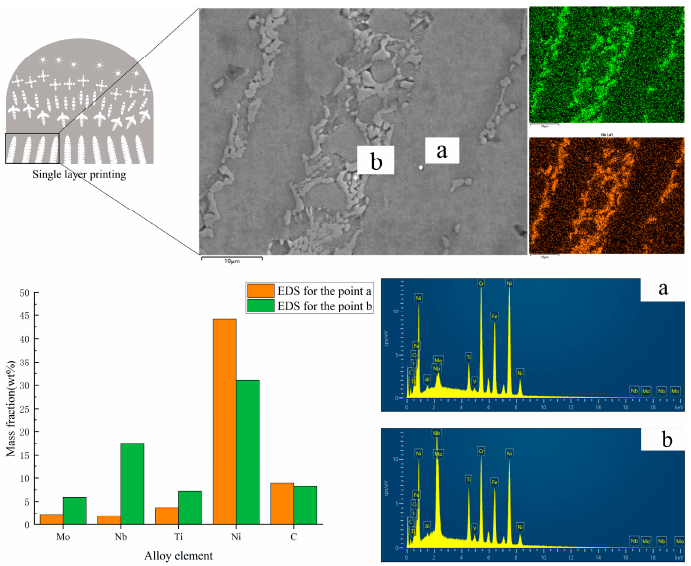
Figure 8. SEM and EDS of the bottom columnar crystal region. a—Columnar crystal branch; b—Interdendritic precipitated phase.